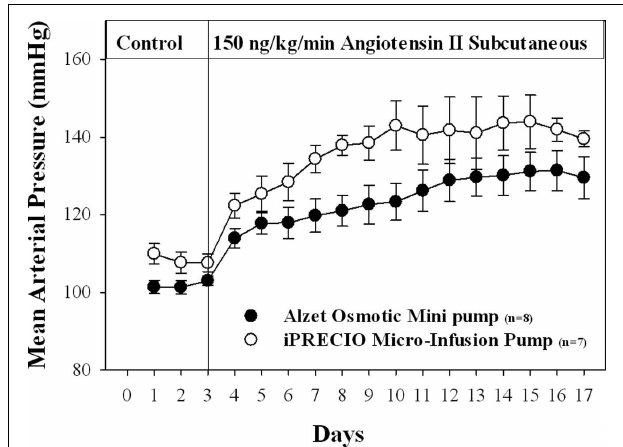
FIGURE 4 | iPRECIO ® appeared to initiate hypertension more rapidly, and maintained a higher level of arterial pressure than the Alzet ® pump. Points represent means ± SEM for number of animals indicated in parentheses ( n ).Vertical line indicates beginning of Angiotensin II infusion.